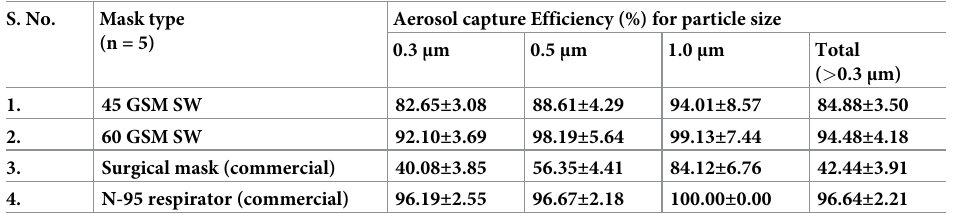
Table 1. Aerosol capture efficiency for test